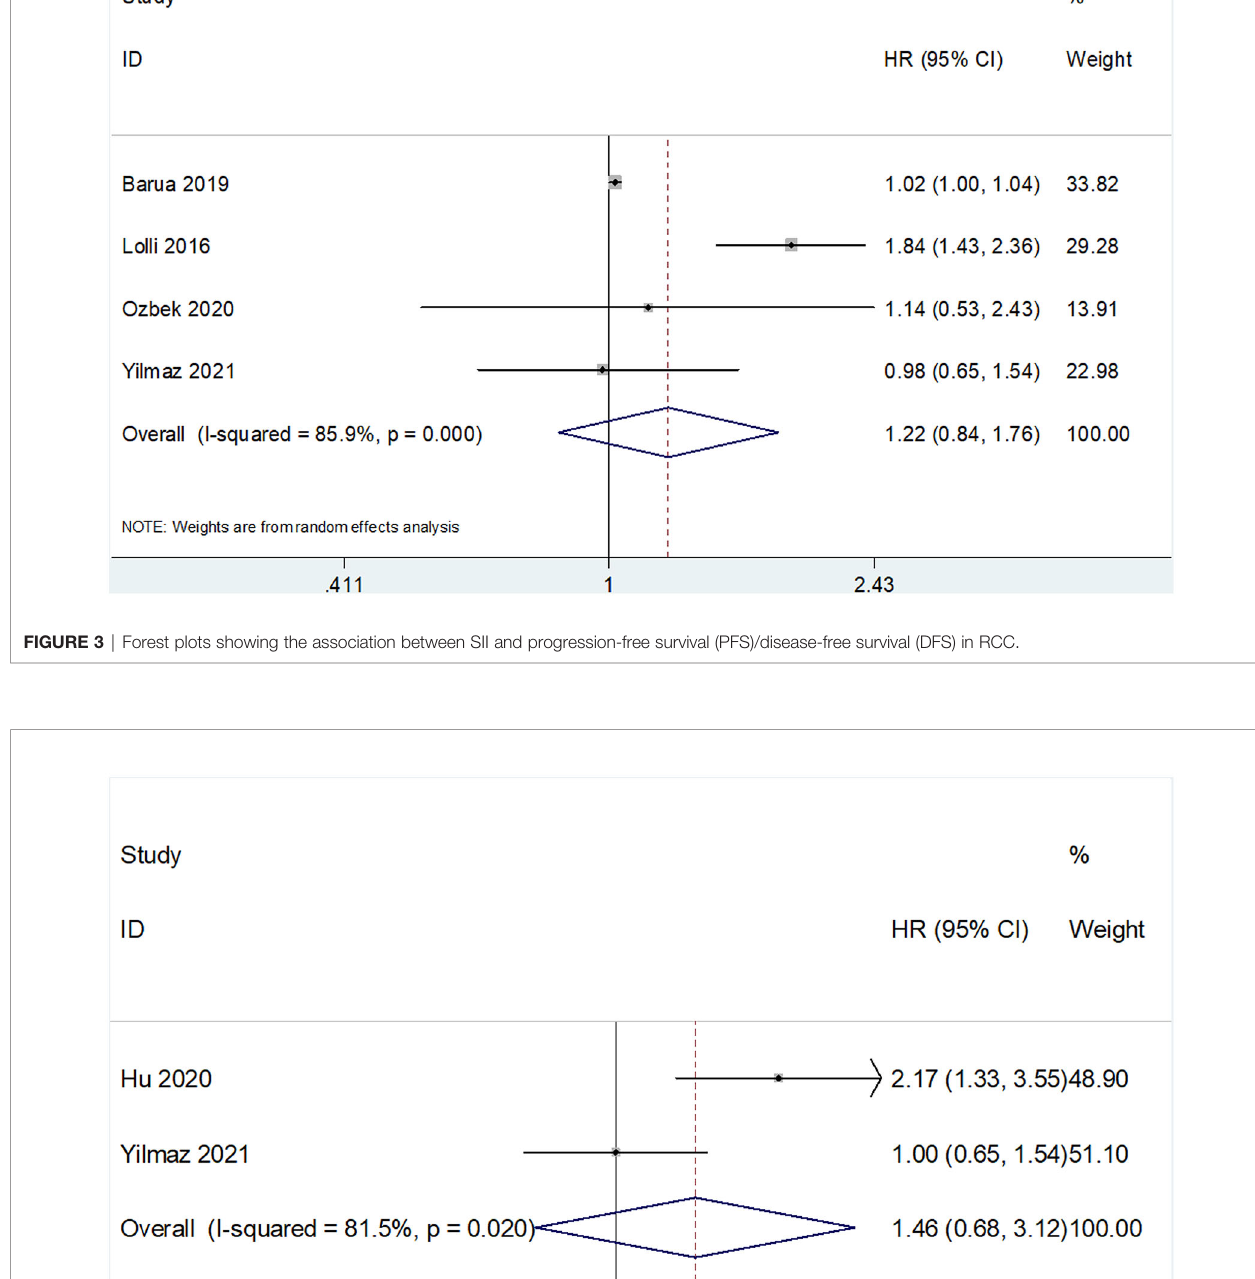
Frontiers in Oncology |